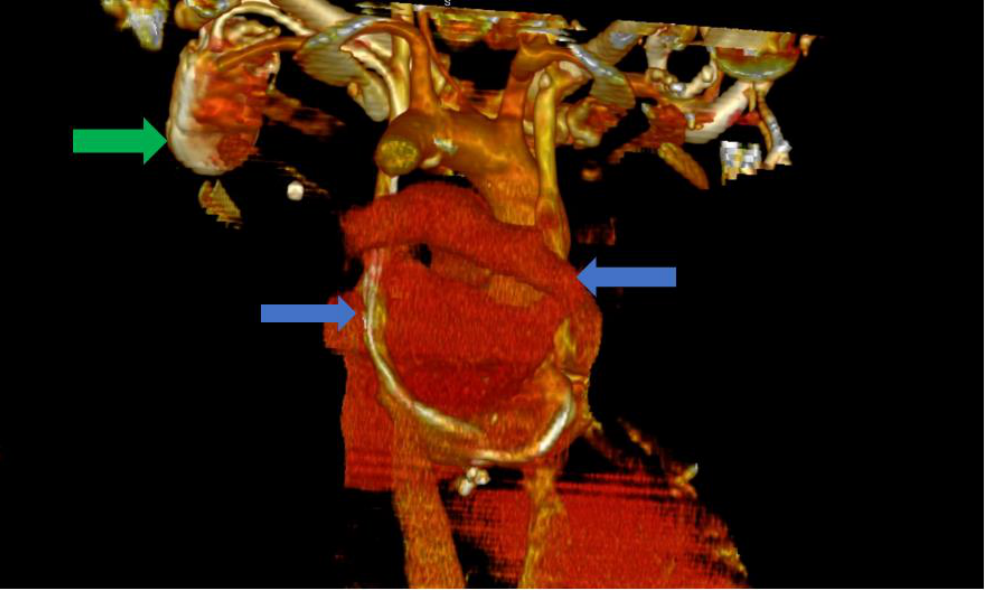
Figure 3. Computer tomography of the heart ang large vessels; in this scenario, a posterior view is provided. We can clearly observe the two superior vena cava (blue arrows) that do not have any communicating branches. In addition, the impulse generator and the adjacent leads can be observed (green arrow).